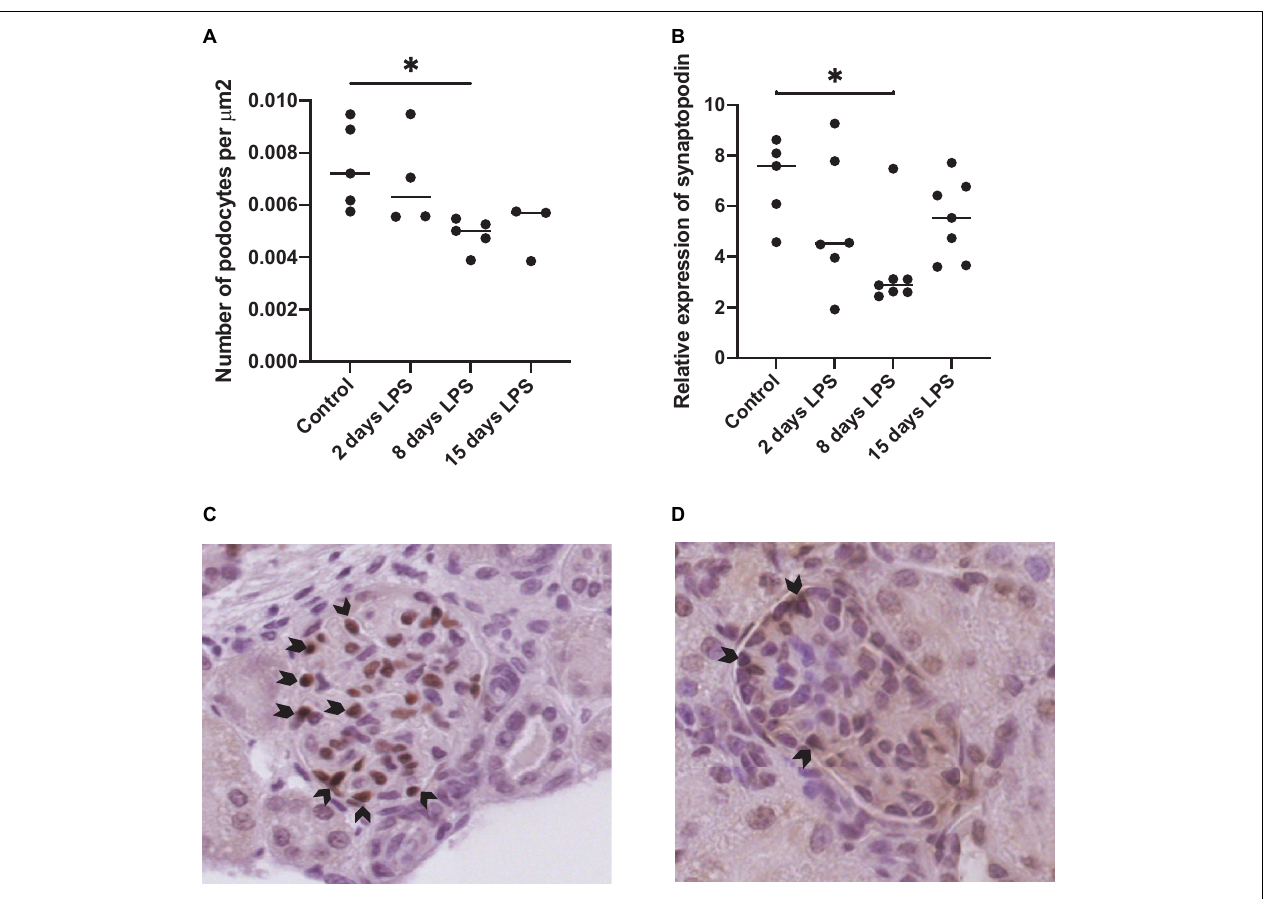
FIGURE 4 | Expression of podocyte markers wilms tumor 1 (WT1) and synaptopodin. Each point represents an individual animal, horizontal line marks the median. Data was analyzed using Kruskal–Wallis test and post hoc Dunn’s test. (A) Number of WT1 positive nuclei per surface area. ∗ p < 0.05 compared with control; (B) aPCR relative expression of synaptopodin. ∗ p < 0.05 compared with control; (C) Representative image of WT1 staining in control; (D) Representative WT1 staining in 8 days lipopolysacharide